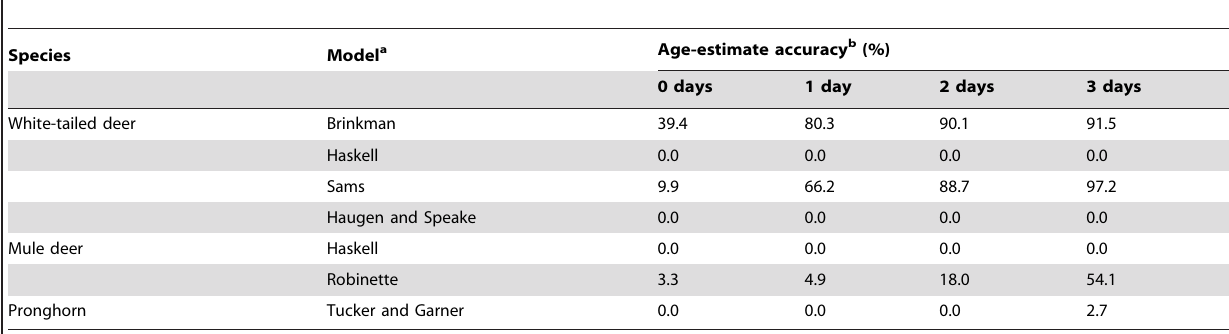
Table 3. Estimated accuracy (%) of neonatal age-classification equations for newborn white-tailed deer ( n =71), mule deer ( n =61), and pronghorn ( n =37) in Minnesota, South Dakota, and California, USA, 2001–2009.